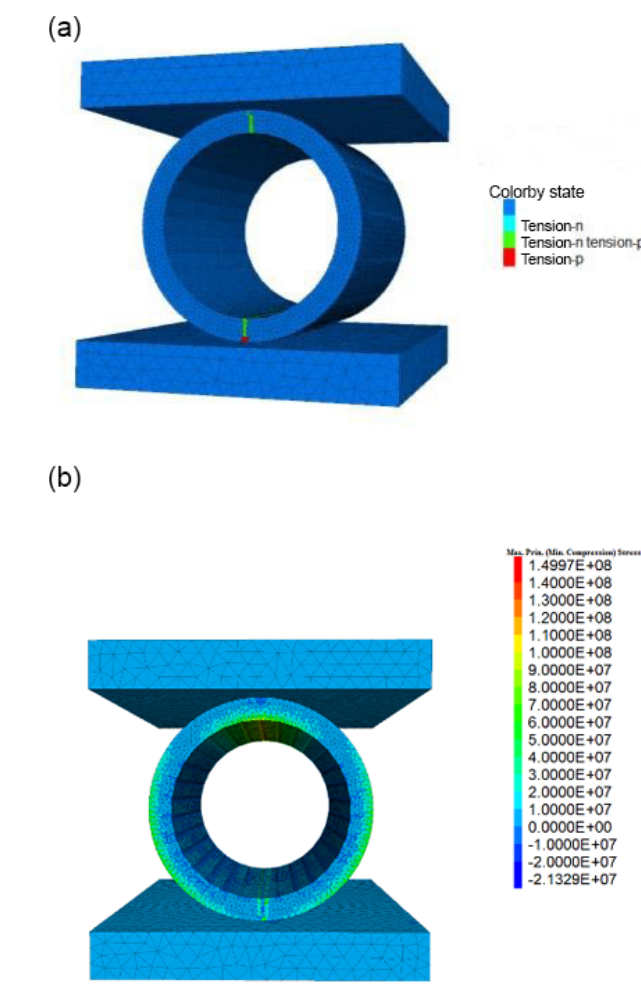
Figure 6. (a) Onset of tensile failure ( T = 150MPa). (b) Post fail- ure maximum principal stress [Pa] ( T = 150MPa).